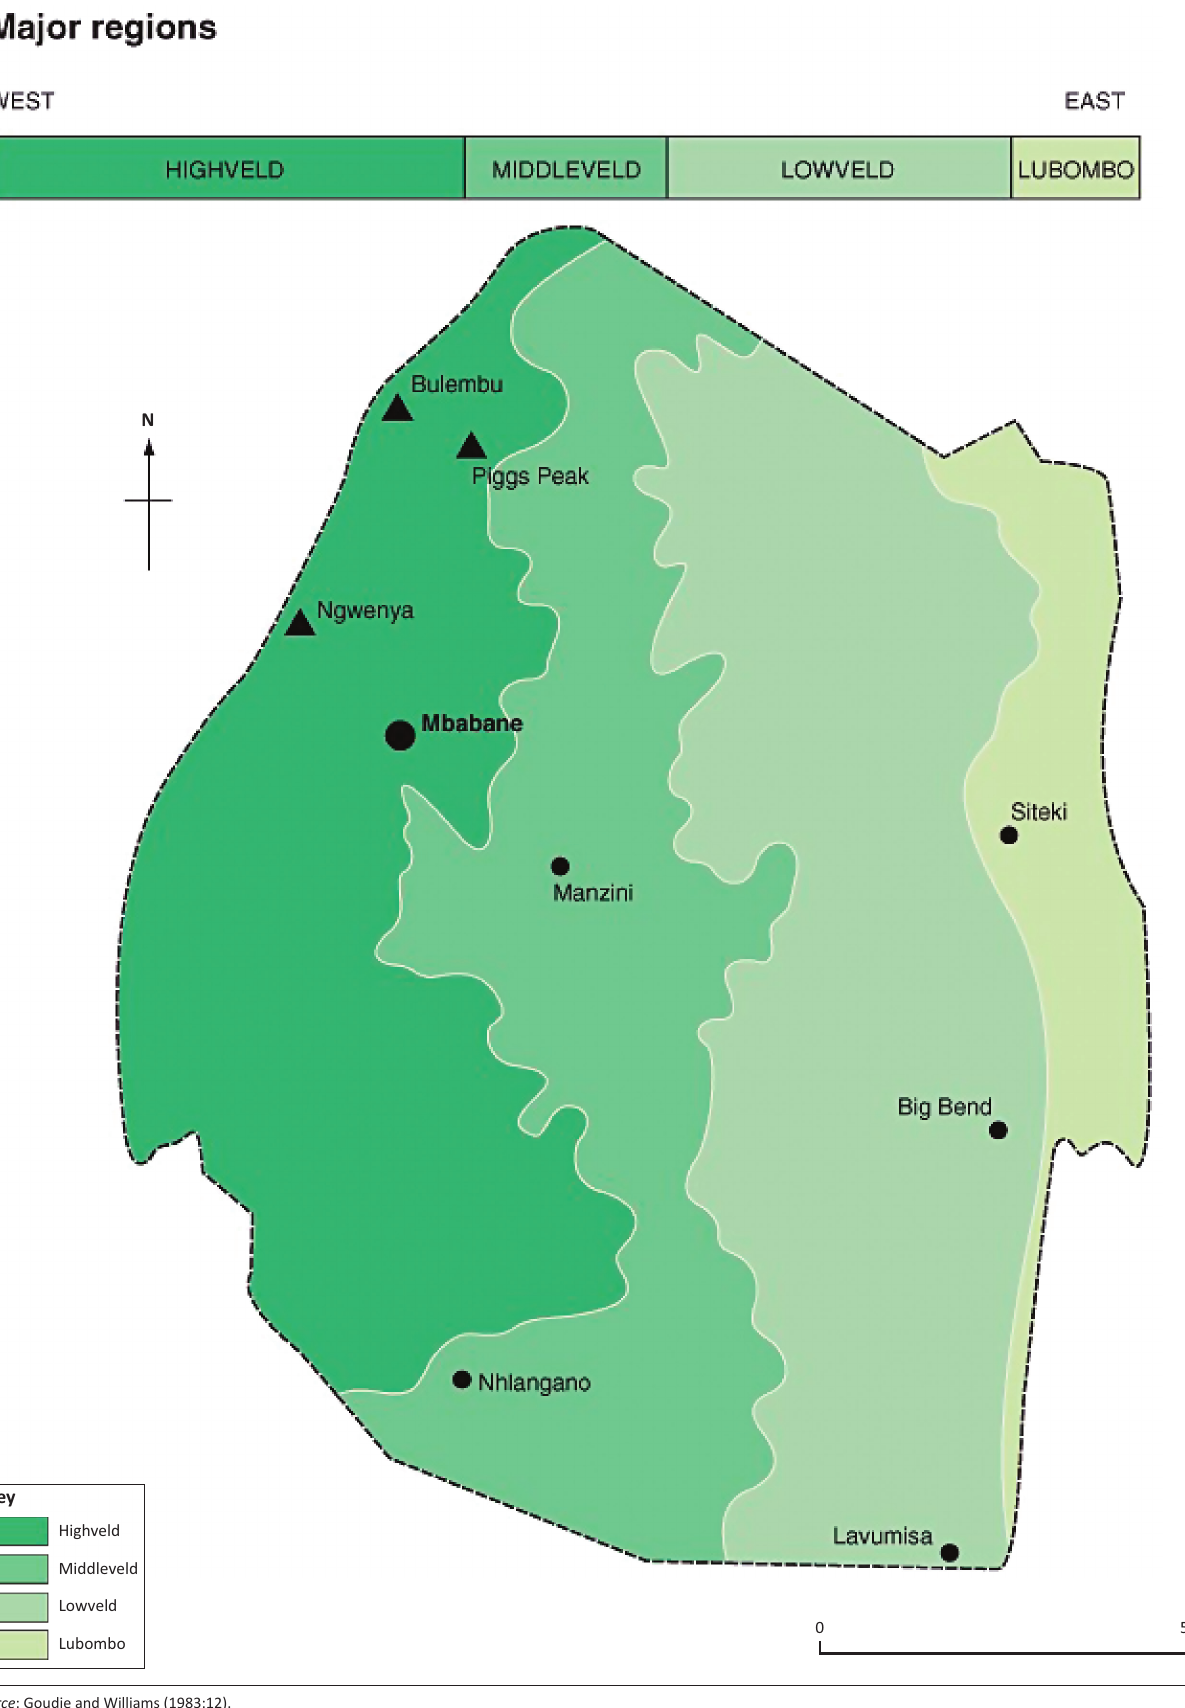
FIGURE 1: Location of study